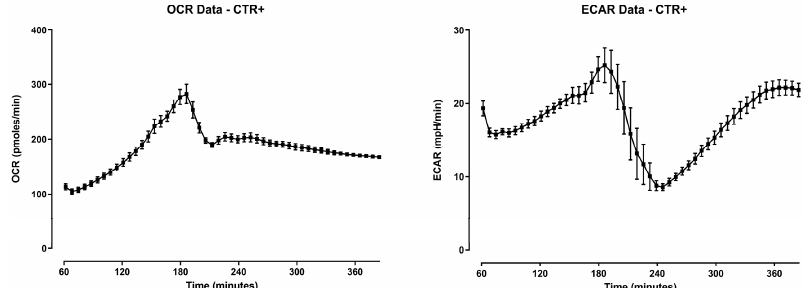
Figure 3. Oxygen consumption rate (OCR) and extracellular acidification rate (ECAR) of HD11 cells infected with Salmonella Enteritidis for 6 h. The reads start from 60 min since, during the first hour, the Seahorse XFp Analyzer requires an internal calibration. Data are expressed as the mean of all the experiments ± SEM ( n = 18).